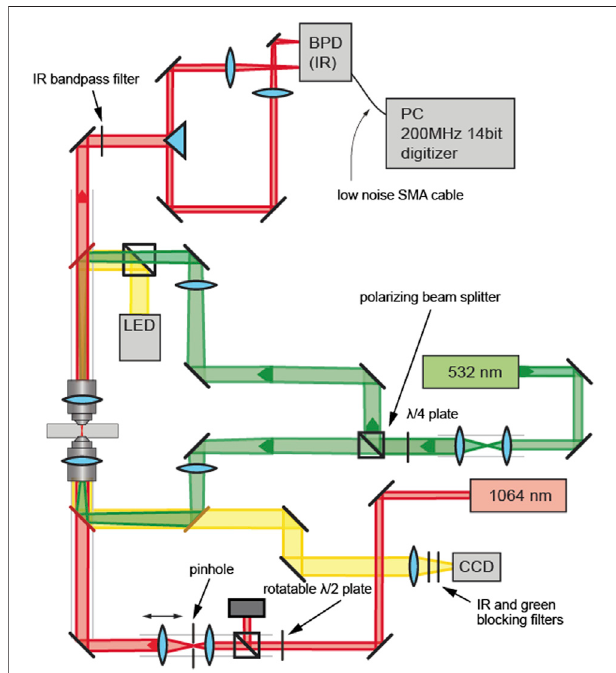
FIGURE 1 | Simpli fi ed schematic of the